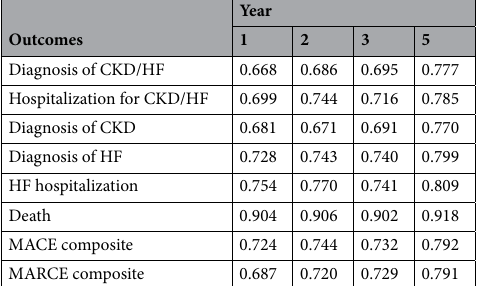
Table 2. AUROCs for the XGB model using top 60 variables and 16 laboratory values. AUROC area under the receiver operating characteristic curve, CKD chronic kidney disease, HF heart failure, MACE major adverse cardiovascular event, MARCE major adverse renal and cardiovascular